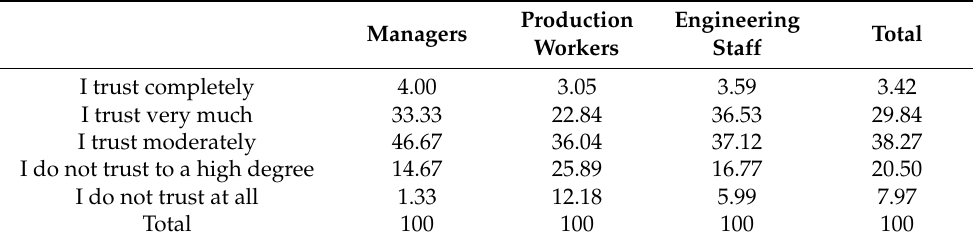
Table 13. Confidence in robots collaborating with humans on the job vs. position in % (N =